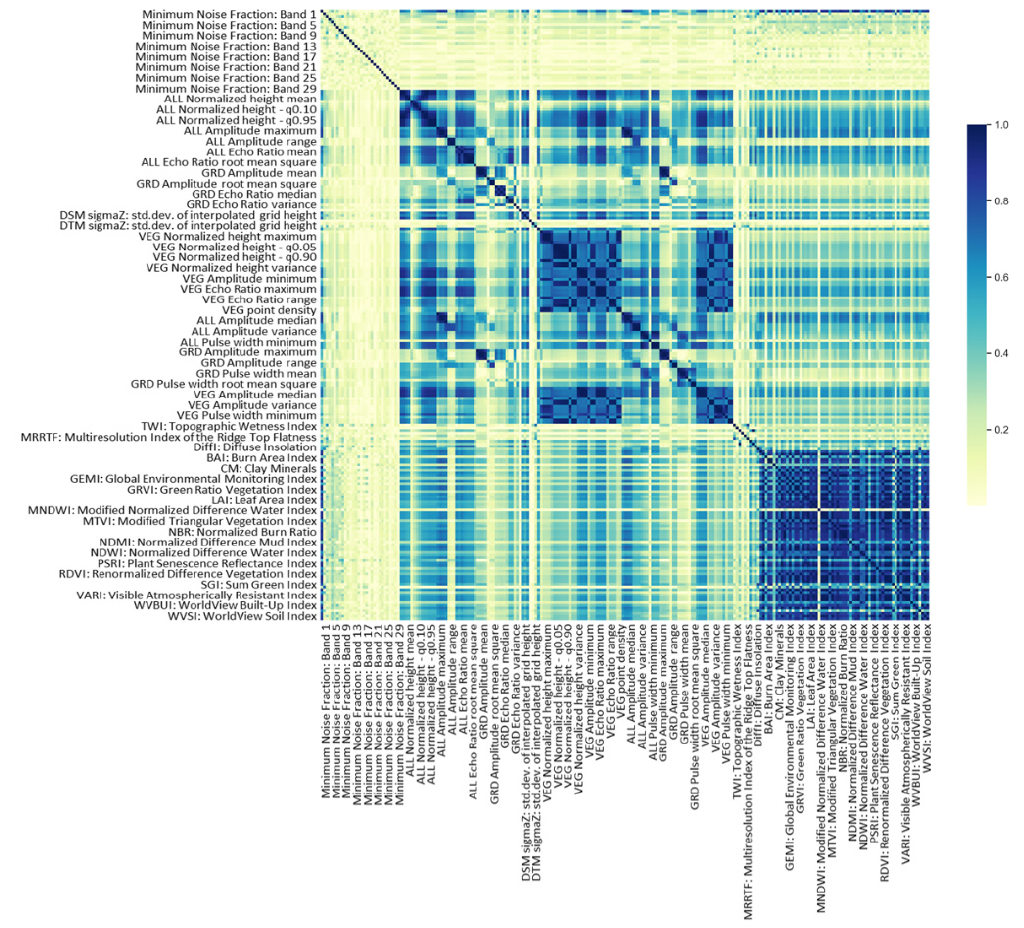
Figure 11. An example of Spearman’s correlation matrix for data acquired in summer in the UB area.